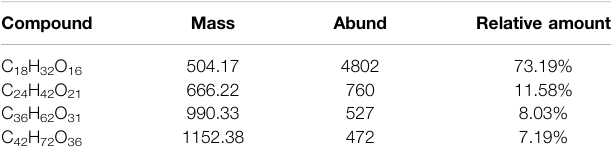
TABLE 3 | LC-MS results of hydrolysates by dextranase Compound Mass Abund Relative